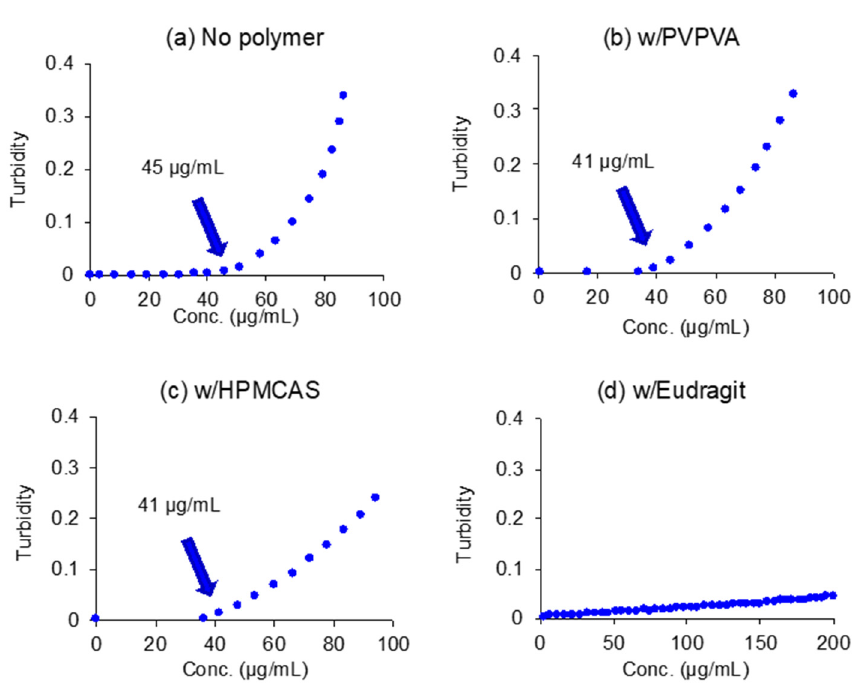
Figure 2. Turbidity of the NFT solutions/suspensions. LLPS concentrations are indicated in the